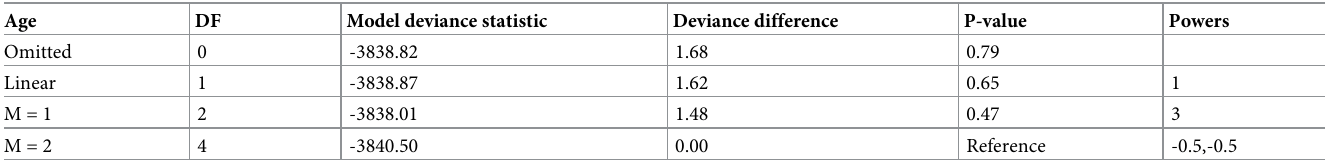
The selection of powers in females followed the same process as that for males. The model with the lowest deviance has powers (-0.5,-0.5). There were no significant differences between the lowest deviance model and the other FP regression models. Model diagnostics were satisfactory. Z-scores followed an approximate normal distribution. A q-norm plot of the SDs was on a straight line. Centile curves are plotted in Fig 2. Top centile curves (90 th -97 th ) peaked in the 30–40 year old age groups but were flatter at the bottom end (3 rd centile). After 30–40 years of age centile curves